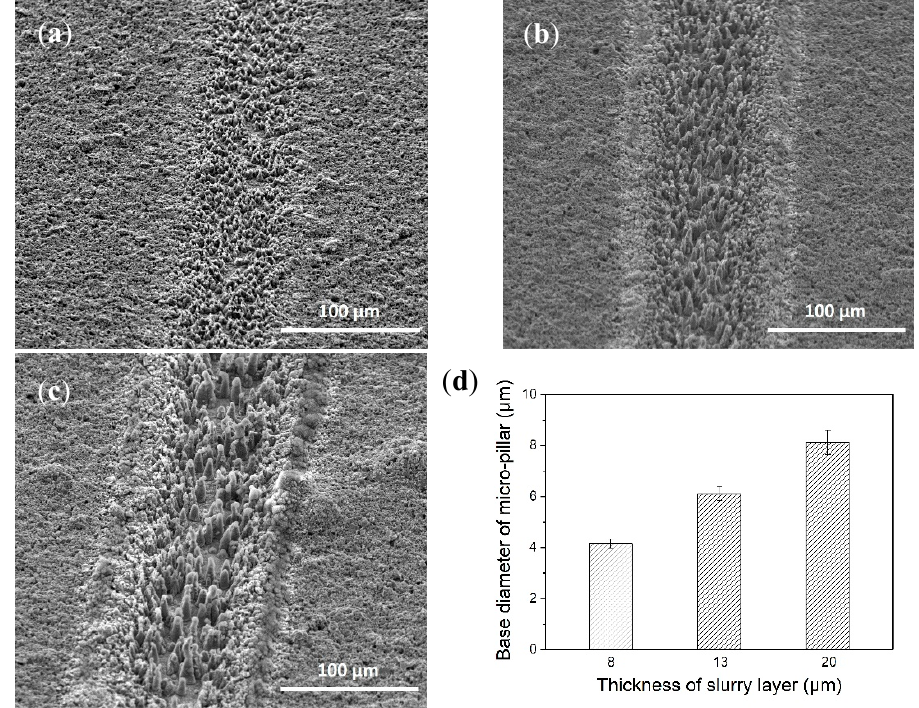
Figure 2. SEM images of Si micropillars growing from slurry layers with thicknesses of ( a ) 8, ( b ) 13 and ( c ) 20 µm. ( d ) Base diameters of micropillars growing from various slurry layer thicknesses.